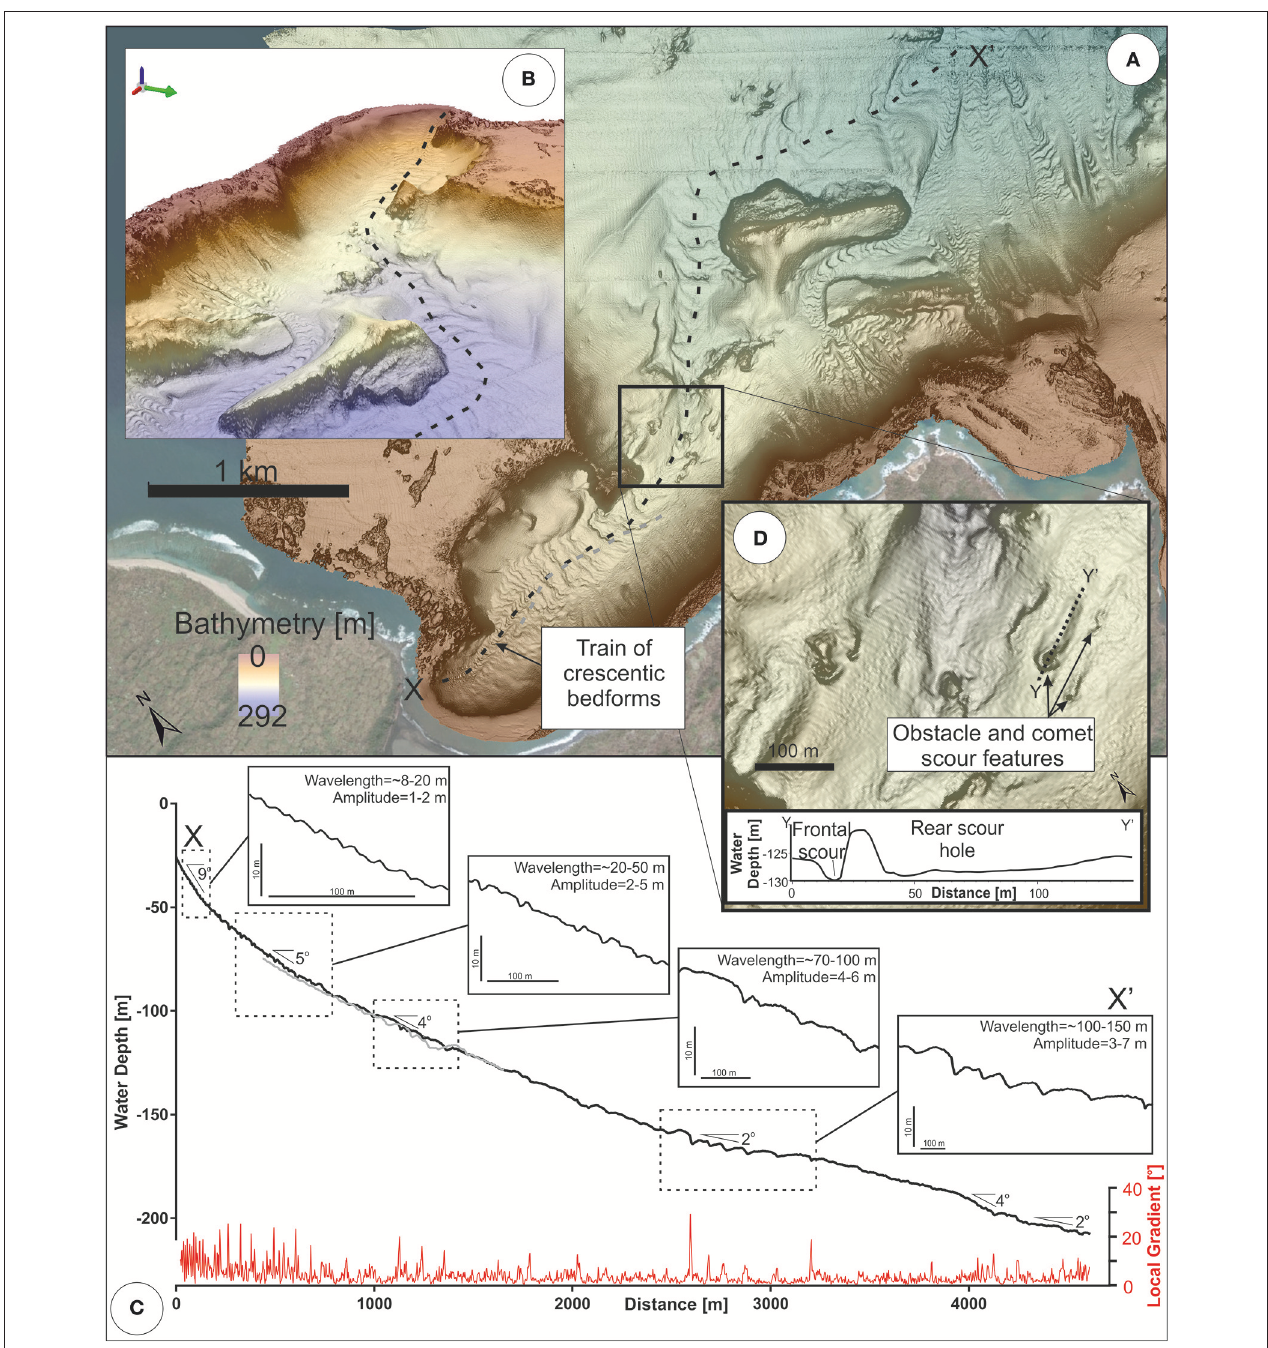
FIGURE 4 | Overview map (A) and 3D rendering (B) annotated with dashed line along the axis of sinuous channel with cresentic bedforms that originates in Sulfur Bay. Along-channel profile (black and gray lines in C ) shows how bedforms generally increase in wavelength and amplitude with increasing water depth. Average slope gradients are annotated on the black profile, while local slope gradient that highlights bedforms and knickpoints is shown as a red line in (C) . Localized obstacle and scour features are shown in (D) .